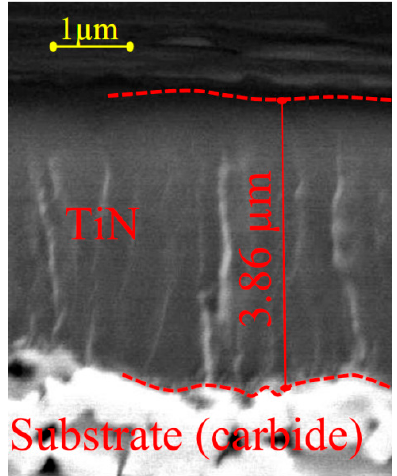
Figure 2. Coating. Average thickness of the coating is 4.0 μ m (S1).